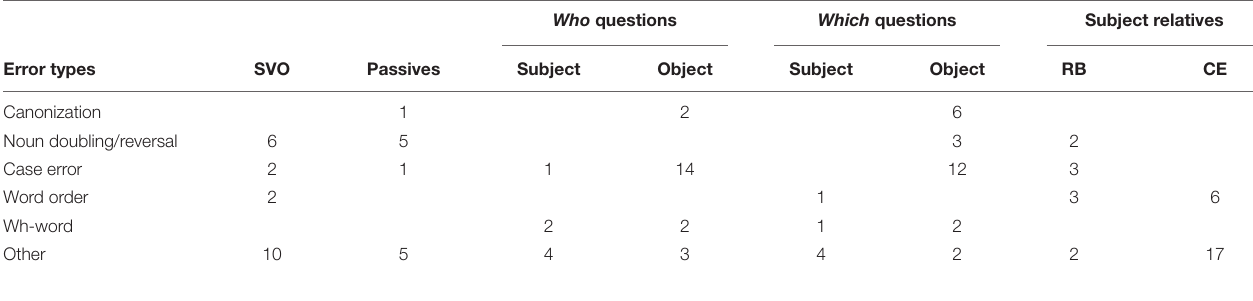
TABLE 7 | Experiment 3- structural errors in repetition: number of errors per sentence